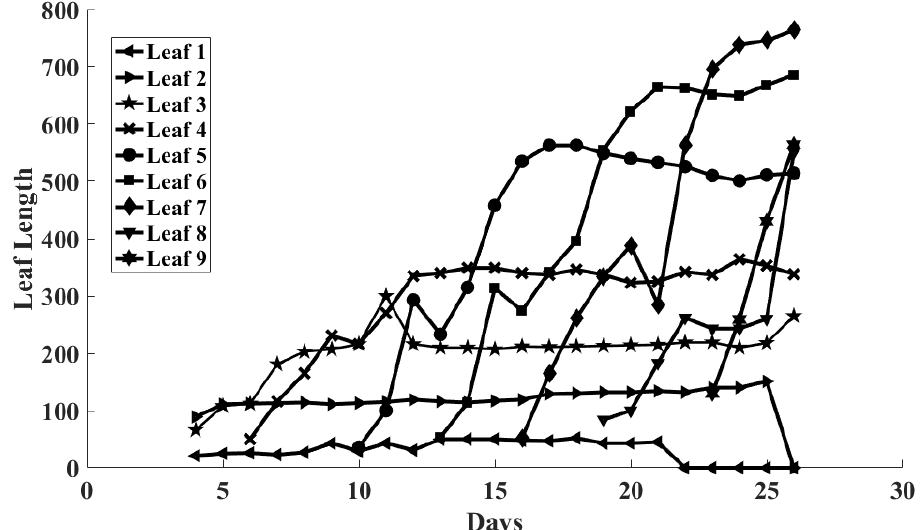
Figure 8. Temporal variation of the length of each leaf starting from